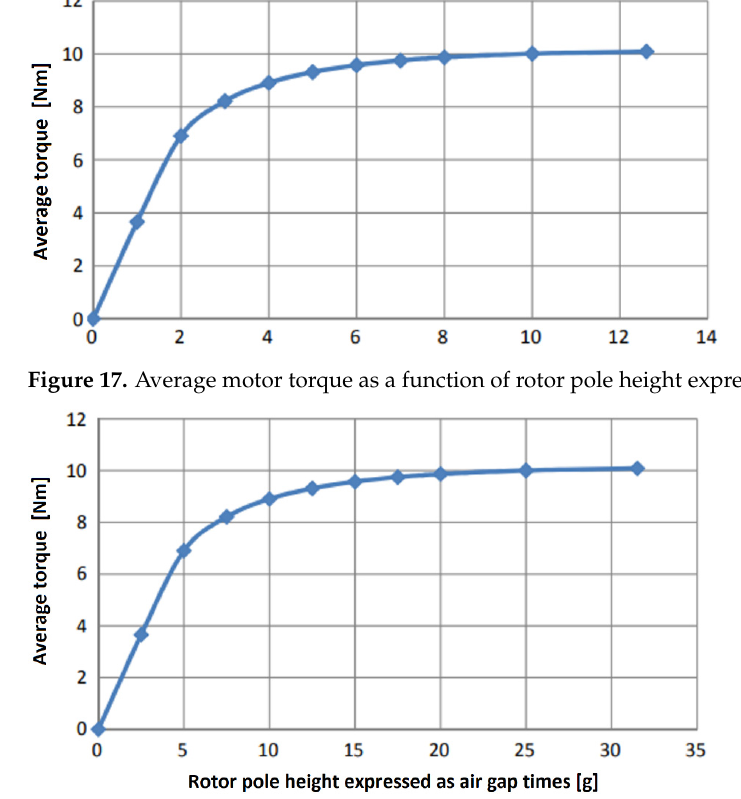
Figure 18. Average motor torque as a function of rotor pole height expressed as air gap times g (gap).